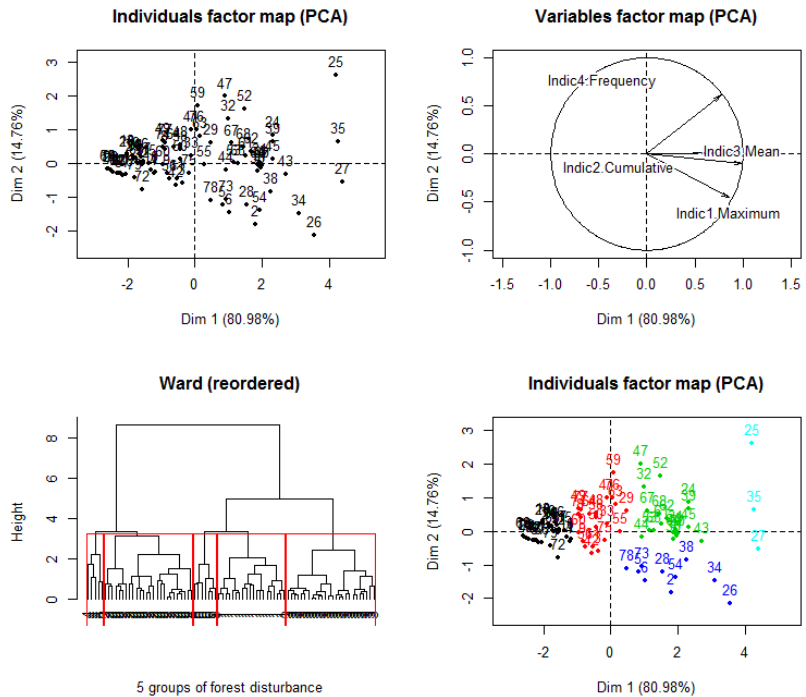
Figure 5. Principal component analysis (PCA) and hierarchical cluster analysis with the Ward’s minimum variance criterion according to the four main indicators of disturbance for the 81 plots and the identification of five groups of forest disturbance.